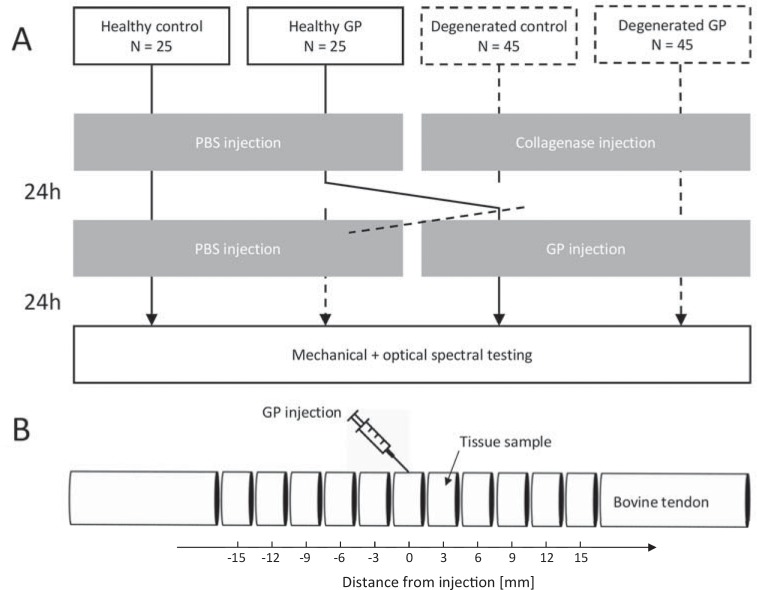
A: Study design and timeline of the main experiment. B: Cubes represent the sites of tissue sample harvesting for optical spectral testing.